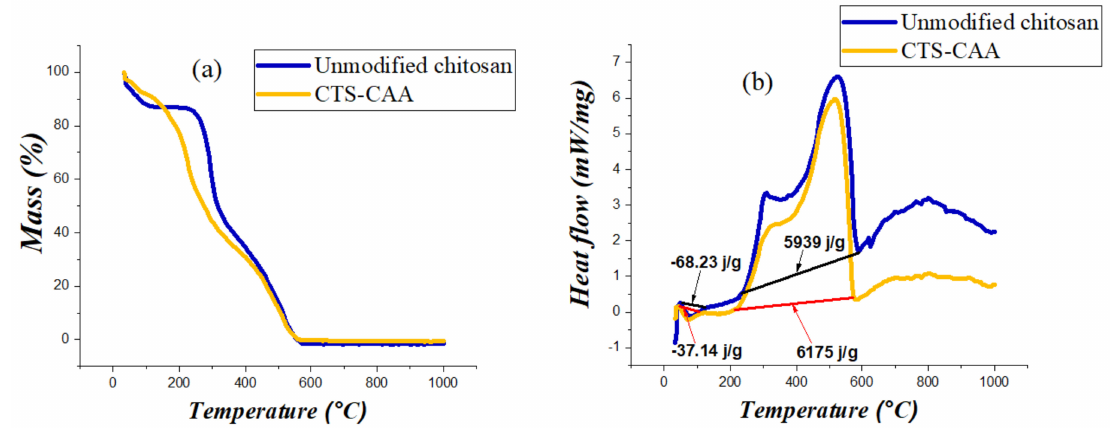
Figure 5. TGA ( a ) and DSC ( b ) curves for unmodified chitosan and